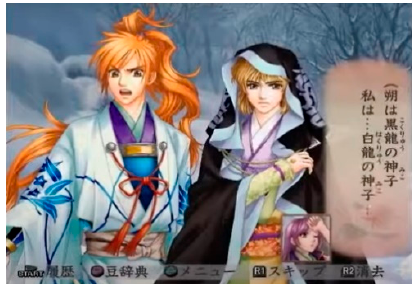
Figure 2. An example from Haruka: Beyond the Stream of Time 3 (Koei 2004). The text is vertical and shown to the right of the screen along with the player character’s own fact to show her feelings. Words in the text box represent her internal thoughts: “Saku is the priestess of the Black Dragon. I’m…the priestess of the White Dragon…” Used with permission.